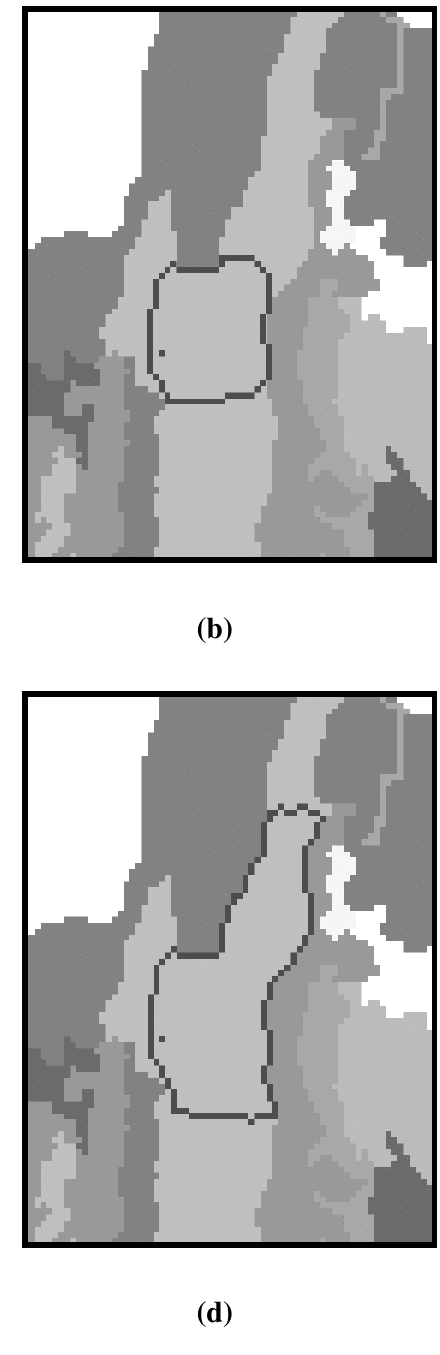
Figure 4. Fire fronts generated by the simulation model for the Mahlala area of MGR displayed after (a) 1 hour (b) 4 hours (c) 6 hours and (d) 8